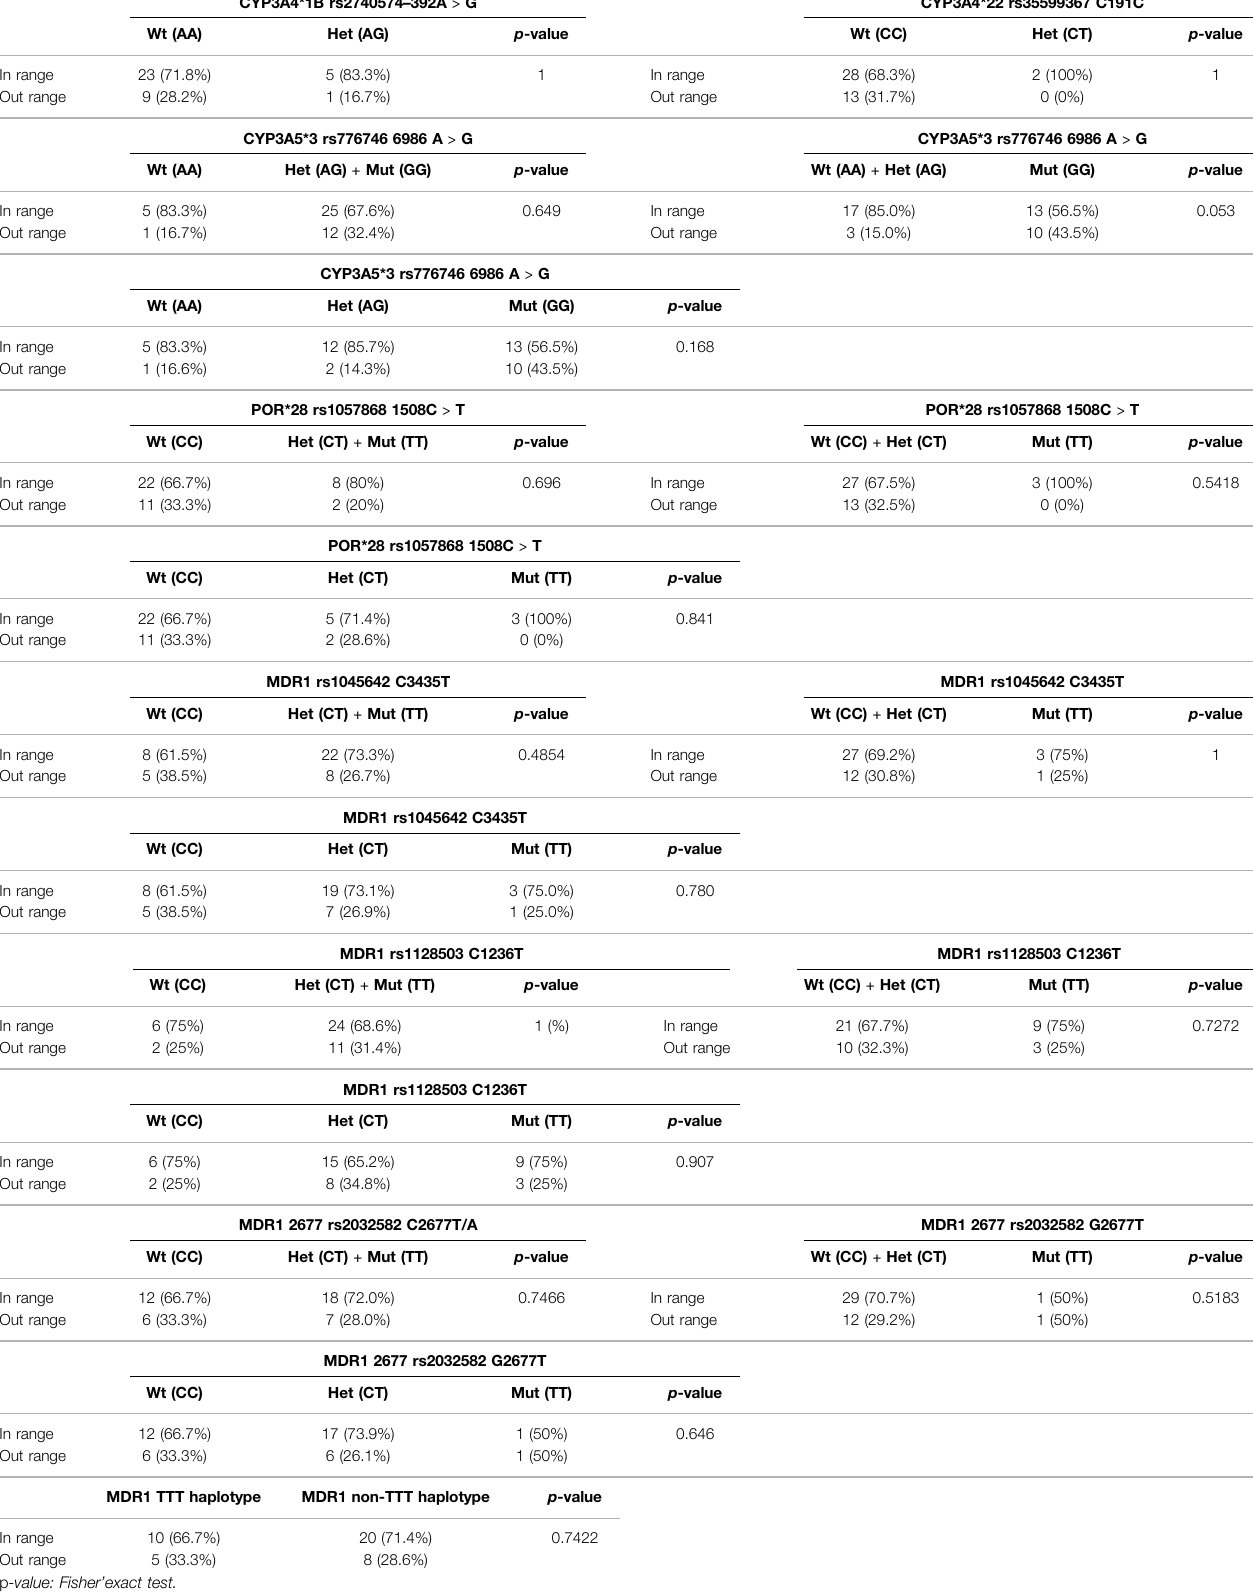
TABLE 3 | Proportion of patients in therapeutic range per